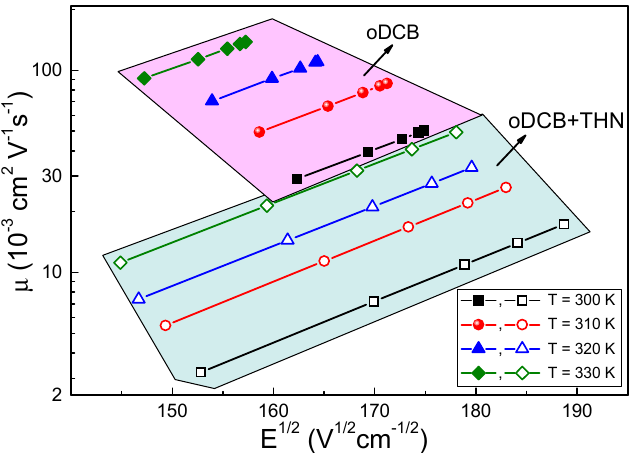
Figure 5. Electron mobility dependence, obtained by noise analysis, on the square root of the applied electric field. The best fitting curves (solid lines) are derived from the Poole-Frenkel model of Equation (4), both for the oDCB solvent (full symbols) and the oDCB+THN solvent (open symbols).